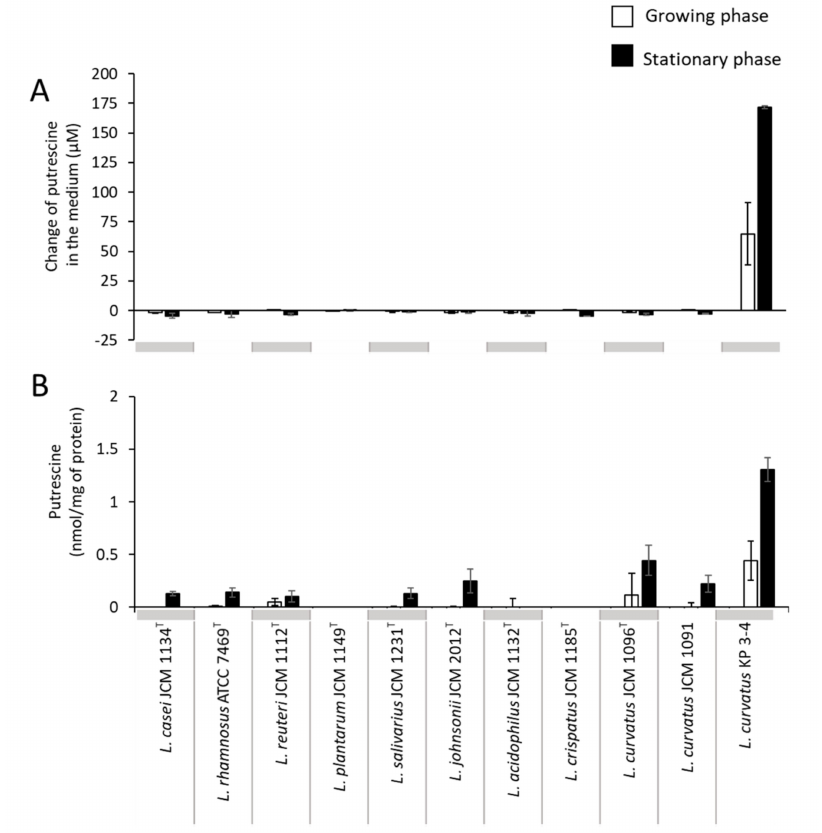
Figure 2. Putrescine concentration in culture supernatant and in the cells of lactic acid bacterial strains. Lactic acid bacterial strains were cultured in the MRS medium anaerobically for a maximum of 82 h at 37 ◦ C. Putrescine concentration in culture supernatant ( A ) and intracellular putrescine concentration ( B ) of the tested lactic acid bacterial strains in the growing phase and stationary phase. For ( A ), the values are shown as changes in the amount of putrescine from the MRS medium to the culture supernatant. White bars, growing phase; black bars, stationary phase. Data represent means ± standard deviation from biological replicates ( n =